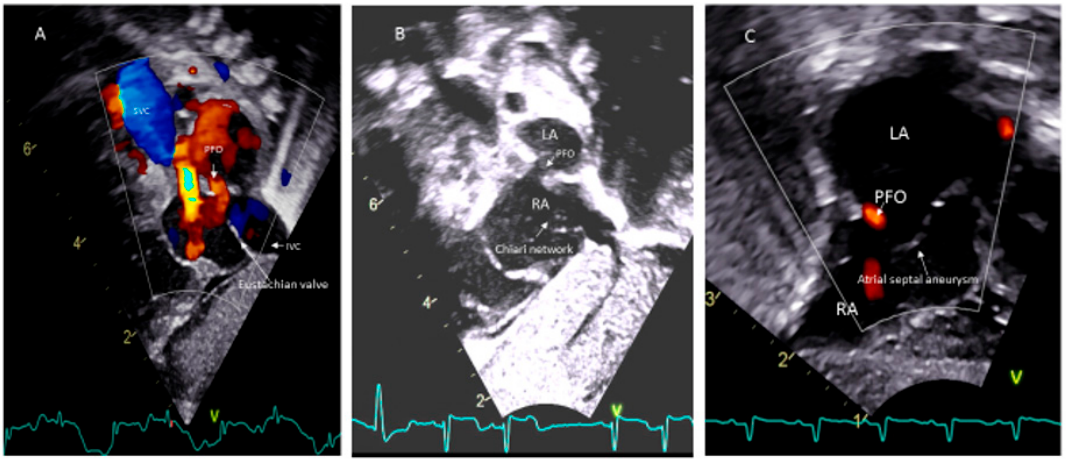
Figure 4. PFO associated with ( A ) Eustachian vale; ( B ) Chiari network; ( C ) Atrial septal aneurysm.